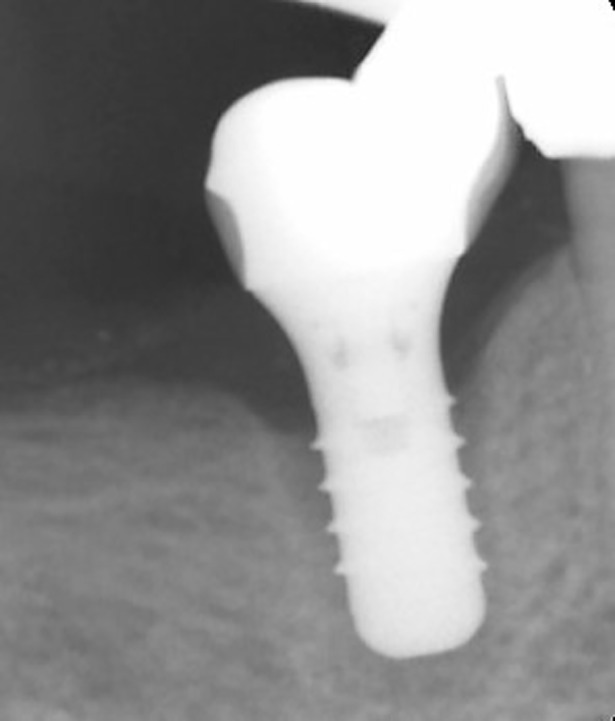
Radiograph that identified a failed implant (3.2 years after implant surgery).